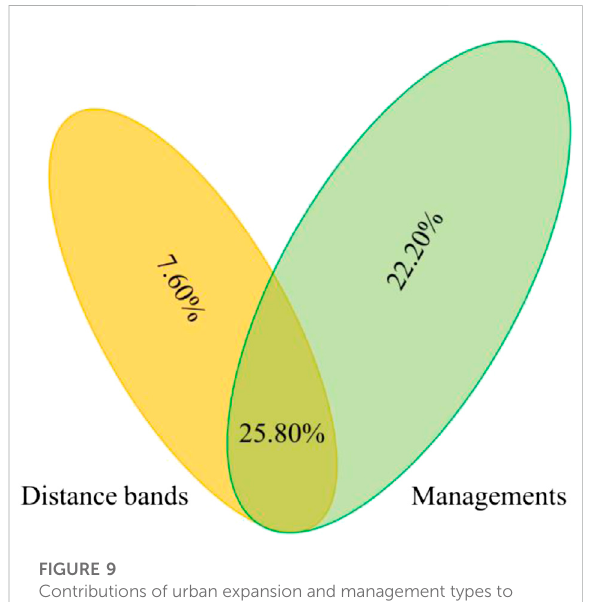
FIGURE 9 Contributions of urban expansion and management types to thevarianceinterpretationofTNandTPconcentrationsandTN:TP ratios (mol/mol) in small water bodies in the study